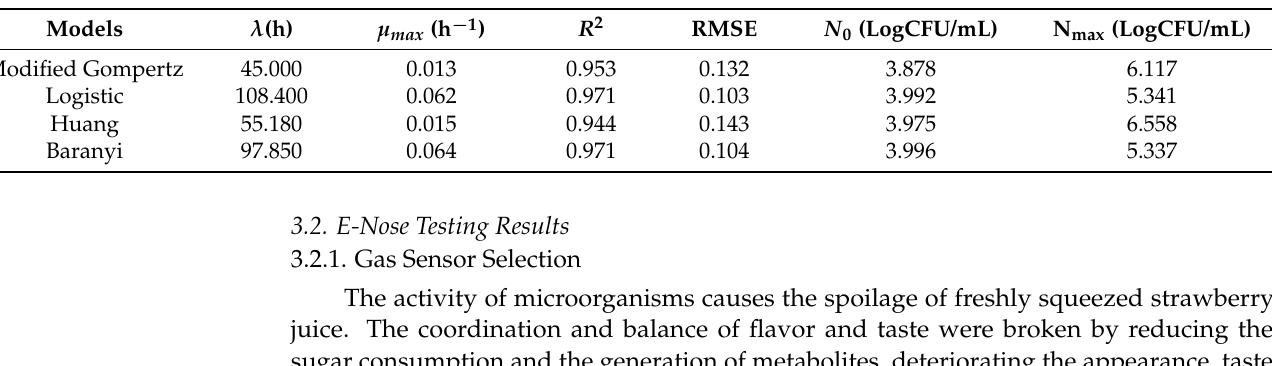
Table 1. Different kinetic-fitting models and parameters of the total bacterial count by traditional plate counting in freshly squeezed strawberry juice during cold storage.